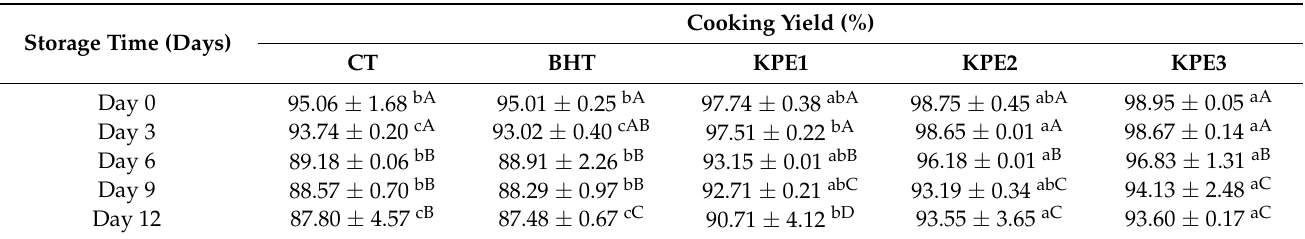
Table 4. Cooking yield of beef sausages during 12 d of refrigerated